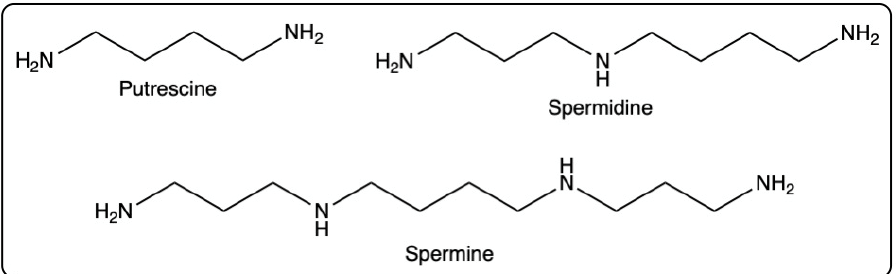
Figure 4. Structures of low molecular weight polyamines used in the prevention of heat-induced aggregation and inactivation of proteins.